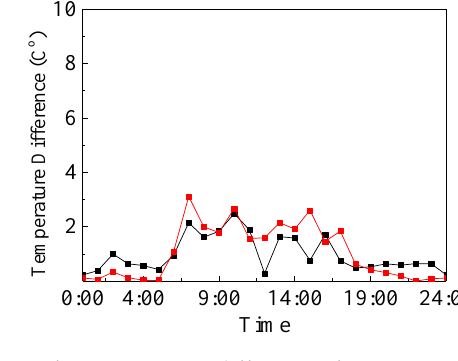
Time ( c ) Temperature difference of W1 to W3 ( d ) Temperature difference of W1 and W6 Figure 6. All-day temperature difference variation curves of various members. Red and black lines indicate the top and bottom test points, respectively. 4. Numerical Simulation of Temperature Field of Spatial Grid Structure 4.1. Finite Element Model According to the experimental design of the spatial grid model, the ANSYS software (ANSYS Inc., Canonsburg, PA, USA) thermal analysis module was used to establish the finite element model for the analysis of the structural temperature field. The assembled triangular support frame was not considered in the numerical model. In the thermal analysis, the three-dimensional shell element, Shell57, was used to simulate the heat conduction of the steel member. The surface effect element, Surf152, which covered the heat conduction element, was used to simulate the convective heat transfer between the structure and the surrounding environment. The thermal radiation element, Link31, was used to simulate the radiation with the sky and ground. Appropriate mesh generation